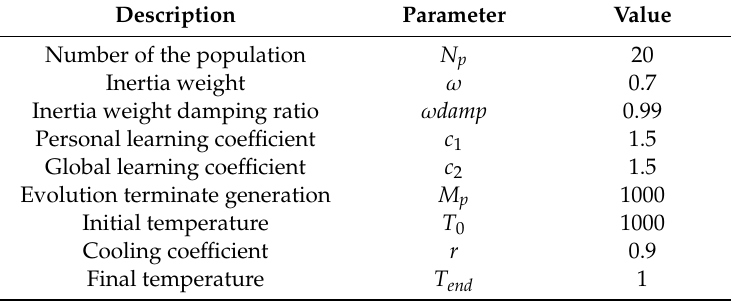
Table 4. Parameters of